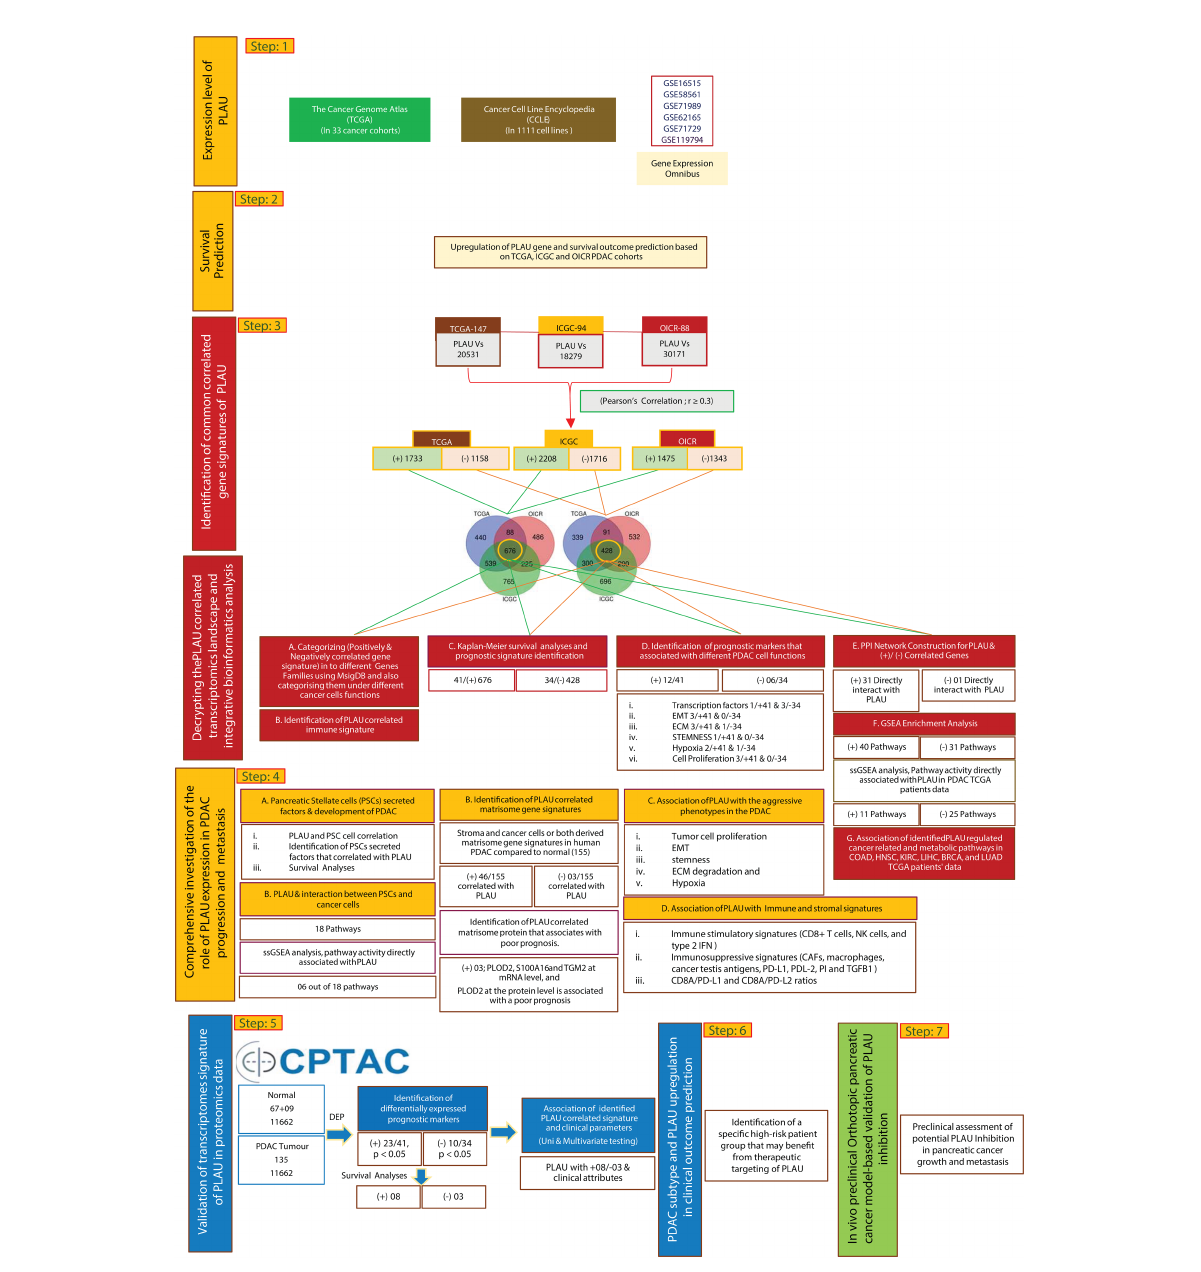
FIGURE 1 An integrative clinical bioinformatics work fl ow to decipher the role of PLAU in PDAC growth and progression, clinical outcome prediction and in vivo preclinical method-based validation of PLAU inhibition effects in tumour growth and